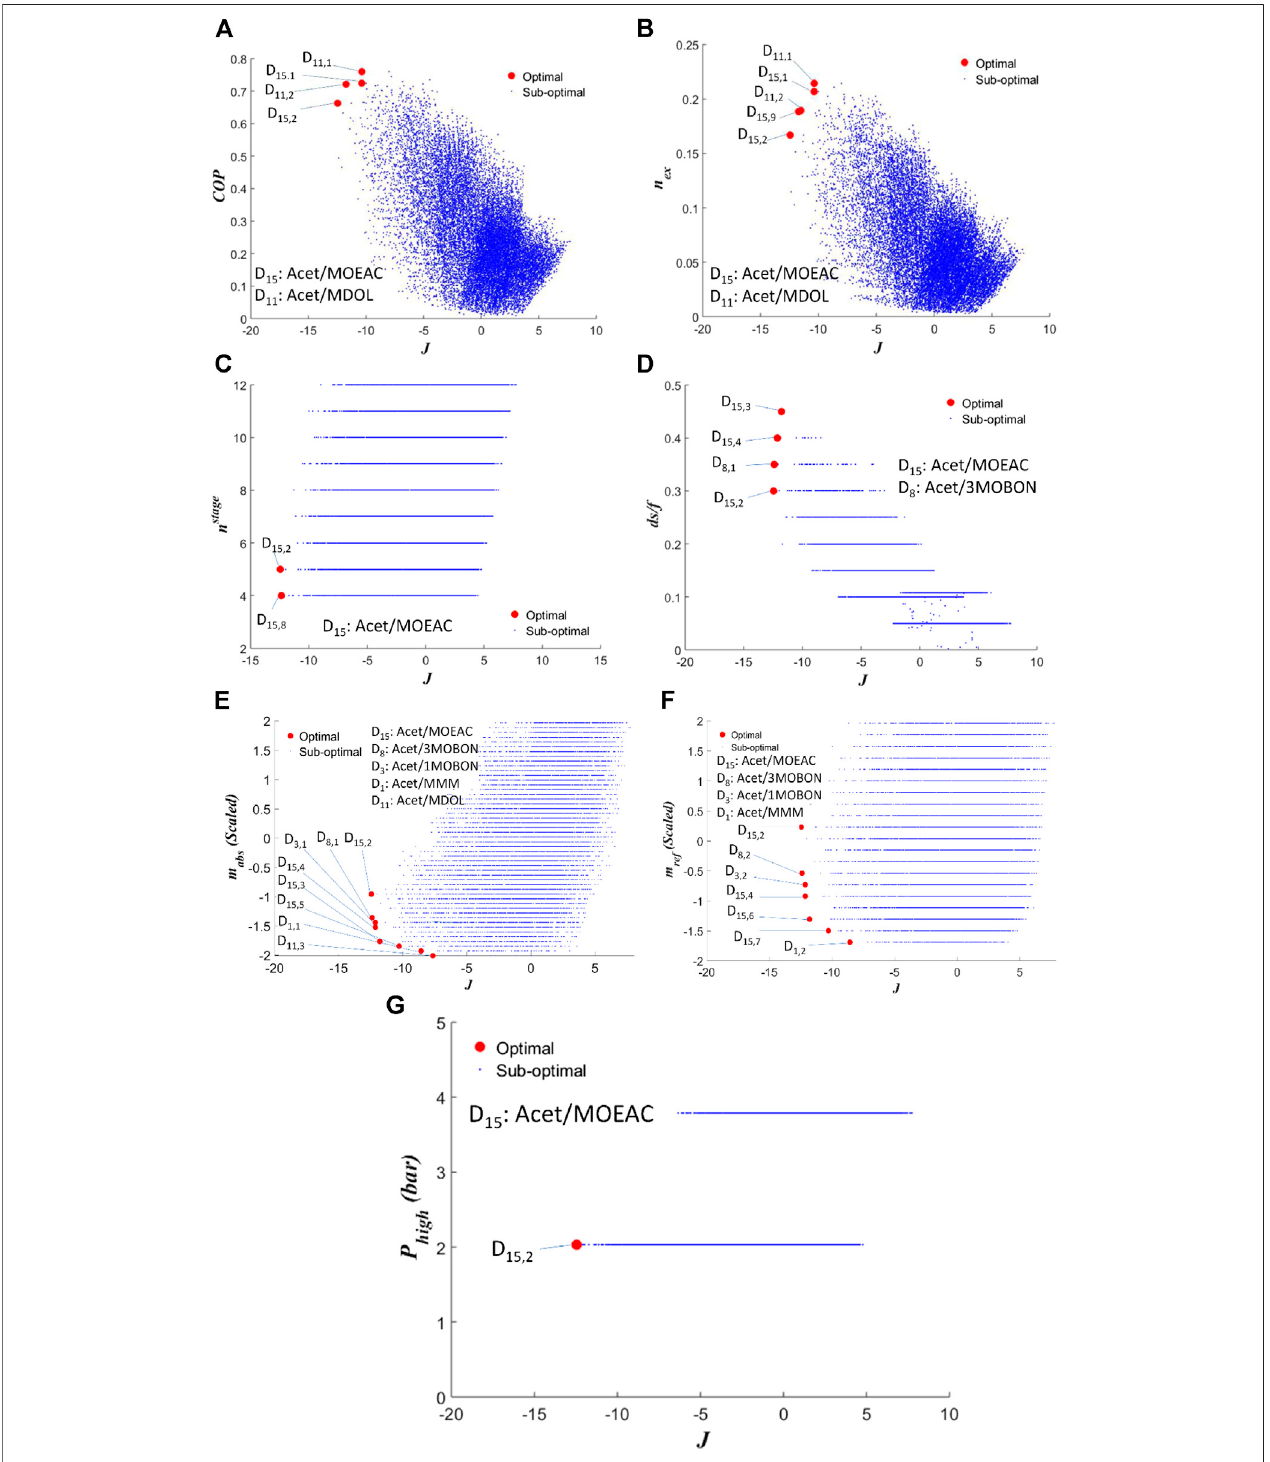
FIGURE 4 | Pareto fronts of (A) COP , (B) n Ex , (C) n stage , (D) ds / f , (E) m abs , (F) m ref , (G) P high , vs. index J . Mixtures that appear multiple times in the same diagrams are different in one or more ABR operating parameters. This is indicated by using a second index, next to the mixture ID (e.g., D 15,1 is different to D 15,2 ). Such data are given only in Supplementary Table S3 of the ESI to maintain the clarity of the fi gures.